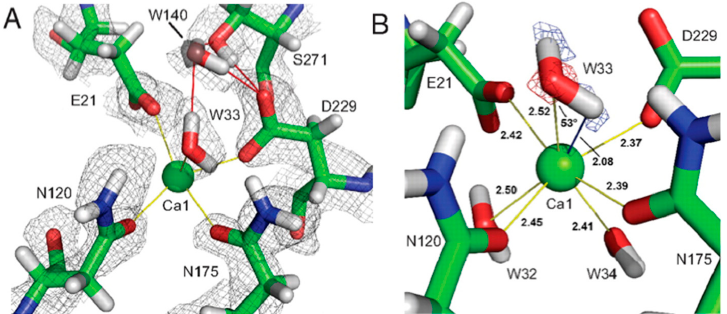
Figure 14. DFPase active site as observed in the neutron crystal structure. ( A ) 2F o − F c nuclear density (gray) shows a deprotonated Asp229; ( B ) Detail of the calcium-binding environment, showing the F o − F c omit density (gray) for the two D atoms in W33. This establishes the identity of W33 as water and not hydroxide. Details surrounding the active site calcium and associated water molecule enable mechanistic studies. Figure reproduced from [47].